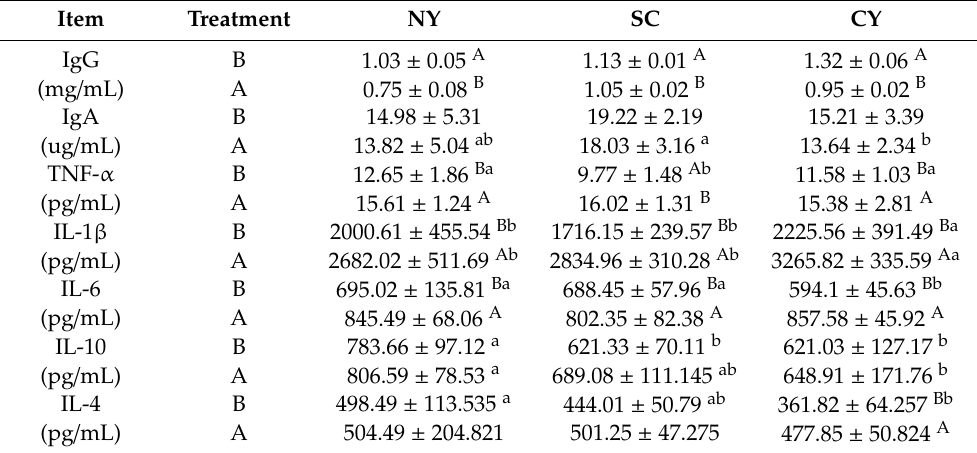
Table 3. Immunity levels before and after